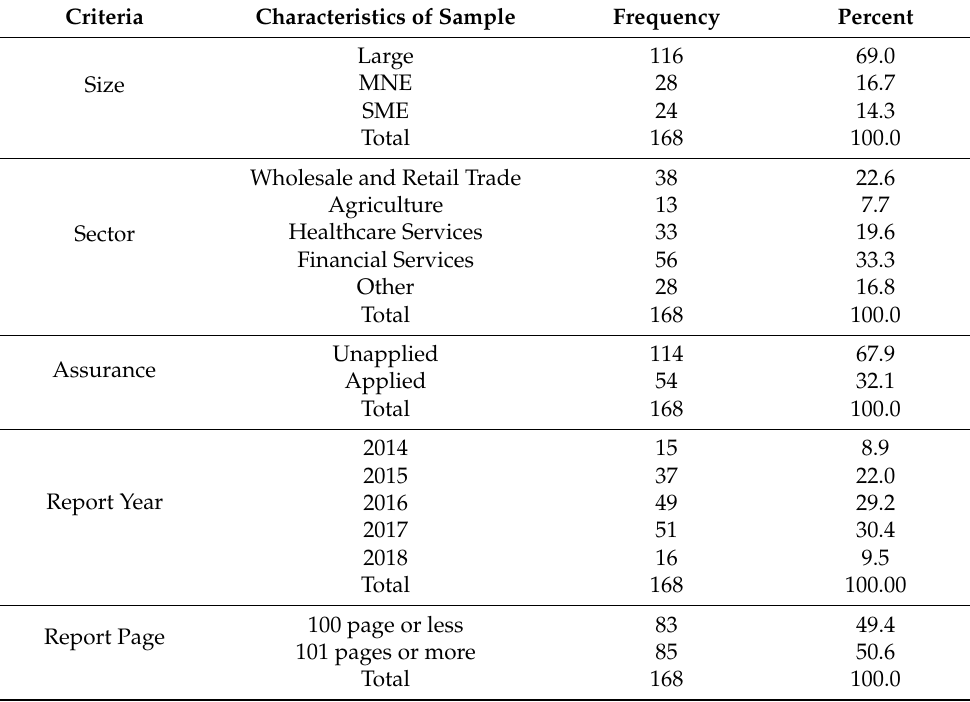
Table 2. Characteristics of the